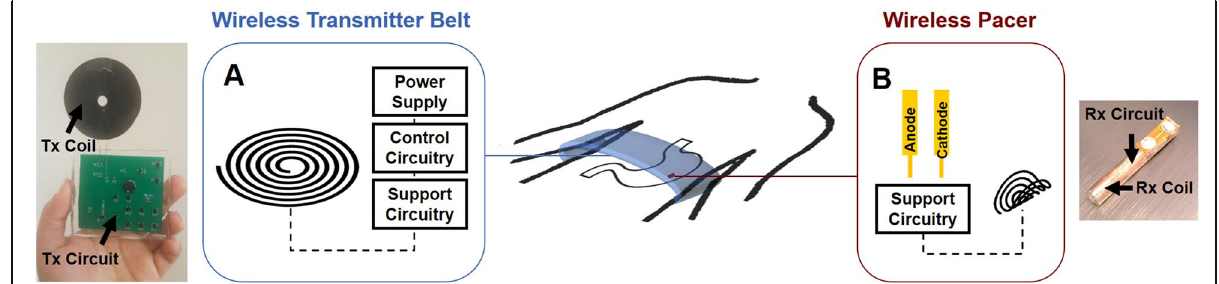
Fig. 1 Gastric Pacer System Design. A Wireless power transmitter (Tx) consisted of a 26 AWG copper wire, shaped into a planar circular coil 40 mm in diameter, a power supply, support circuitry with a power amplifier and tank circuit, and control circuitry to regulate pacing frequency, duration, and amplitude. B Wireless pacer consisted of a 30 AWG copper wire, folded into a semi-cylindrical power-receiving (Rx) coil 2.8 mm in diameter and 15 mm in length, a pair of platinum treated copper electrodes, and a support circuity with a tank circuit and AC-DC converter. For insulation against the conductive blood, the internal components were encapsulated by polydimethylsiloxane. The transmitter would ultimately take the form factor of an external belt to control the intravascular implanted gastric pacer on the stomach serosal